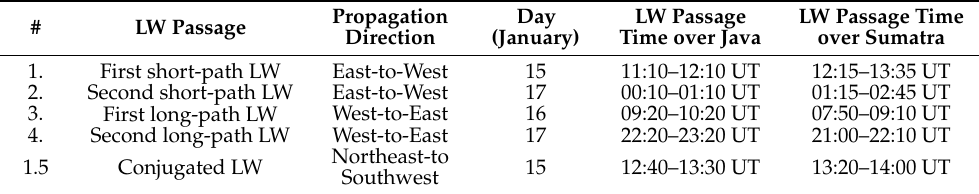
Table 1. Expected passage time ranges of LW (0.3 km/s) from HTHH.